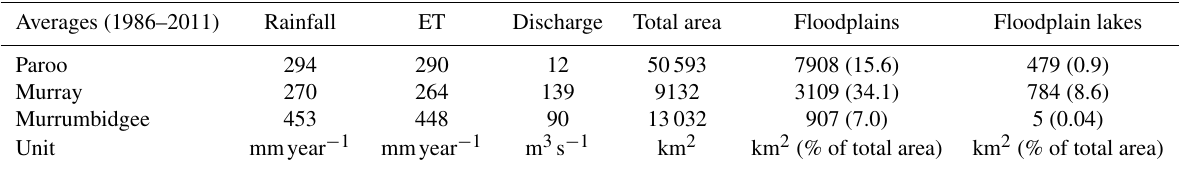
Table 4. Long-term average climate and runoff characteristics along with total, floodplain, and floodplain-lake area of the three sub-regions used for illustration of the spatial modeling framework.